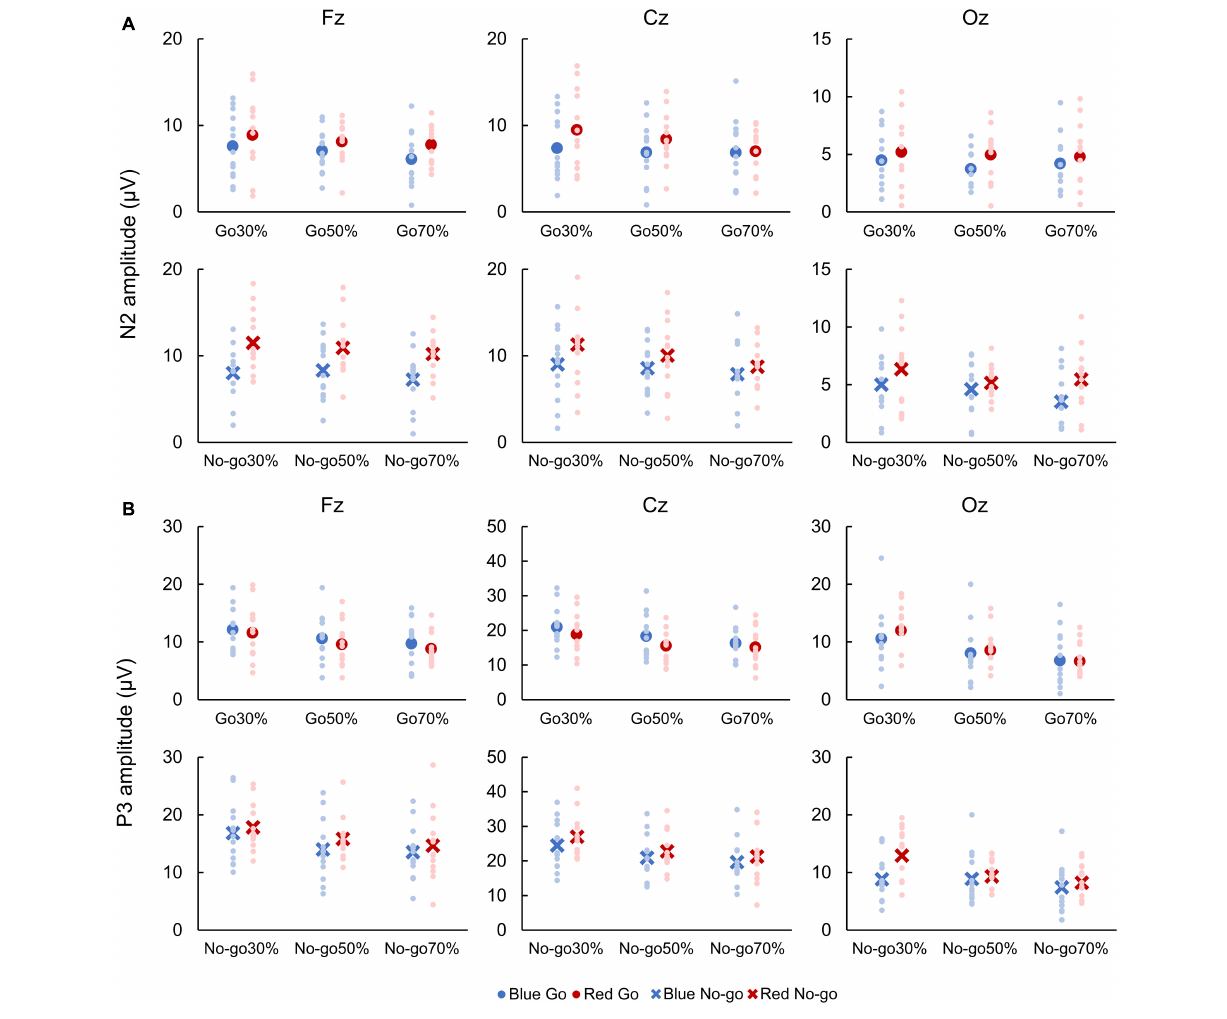
FIGURE 4 | Amplitudes of N2 (A) and P3 (B) . Blue color indicates responses to a blue light (Blue Go and Blue No-go), and red color indicates responses to a red light (Red Go and Red No-go). Individual data (light color) and their mean (dark color) were presented for each